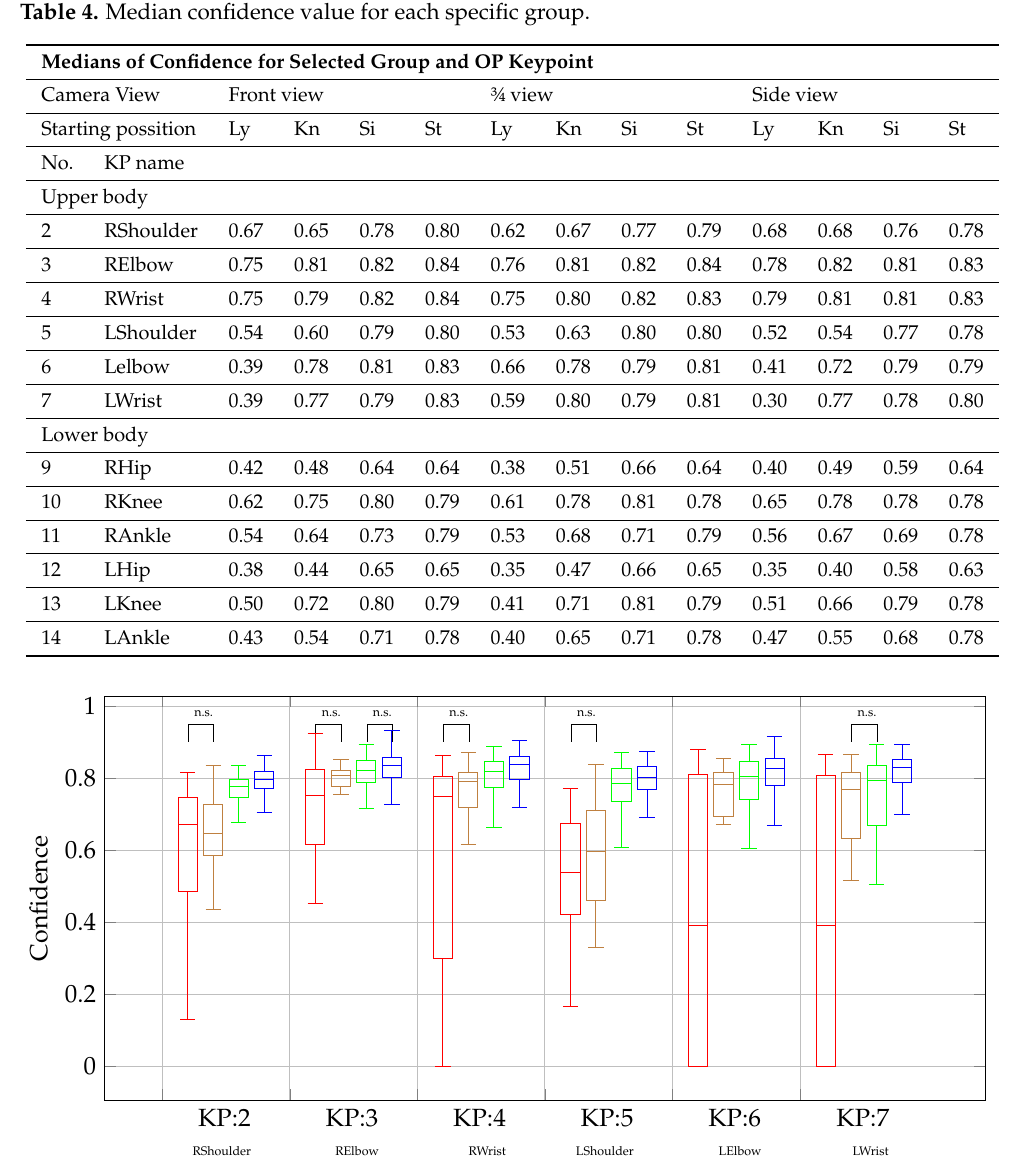
Figure 4. Confidence of detection of selected KP (keypoints)—front view, upper body. Camera views are shown in colour as follows: lying down ( N = 75); on the knees ( N = 26); sitting ( N = 186); and standing ( N = 70). All the other differences are statistically significant. Only differences that were not statistically significant (n.s.) are highlighted in the